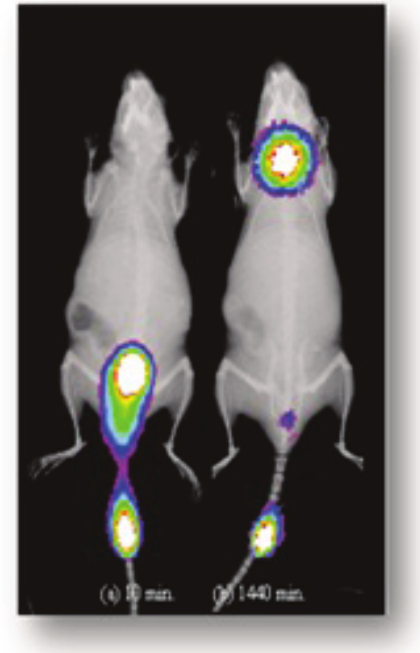
FIGURE 6 -Static images of Peak 7 radiolabeled with 131 I were obtained at 10 and 1440 min. on male Balb-C